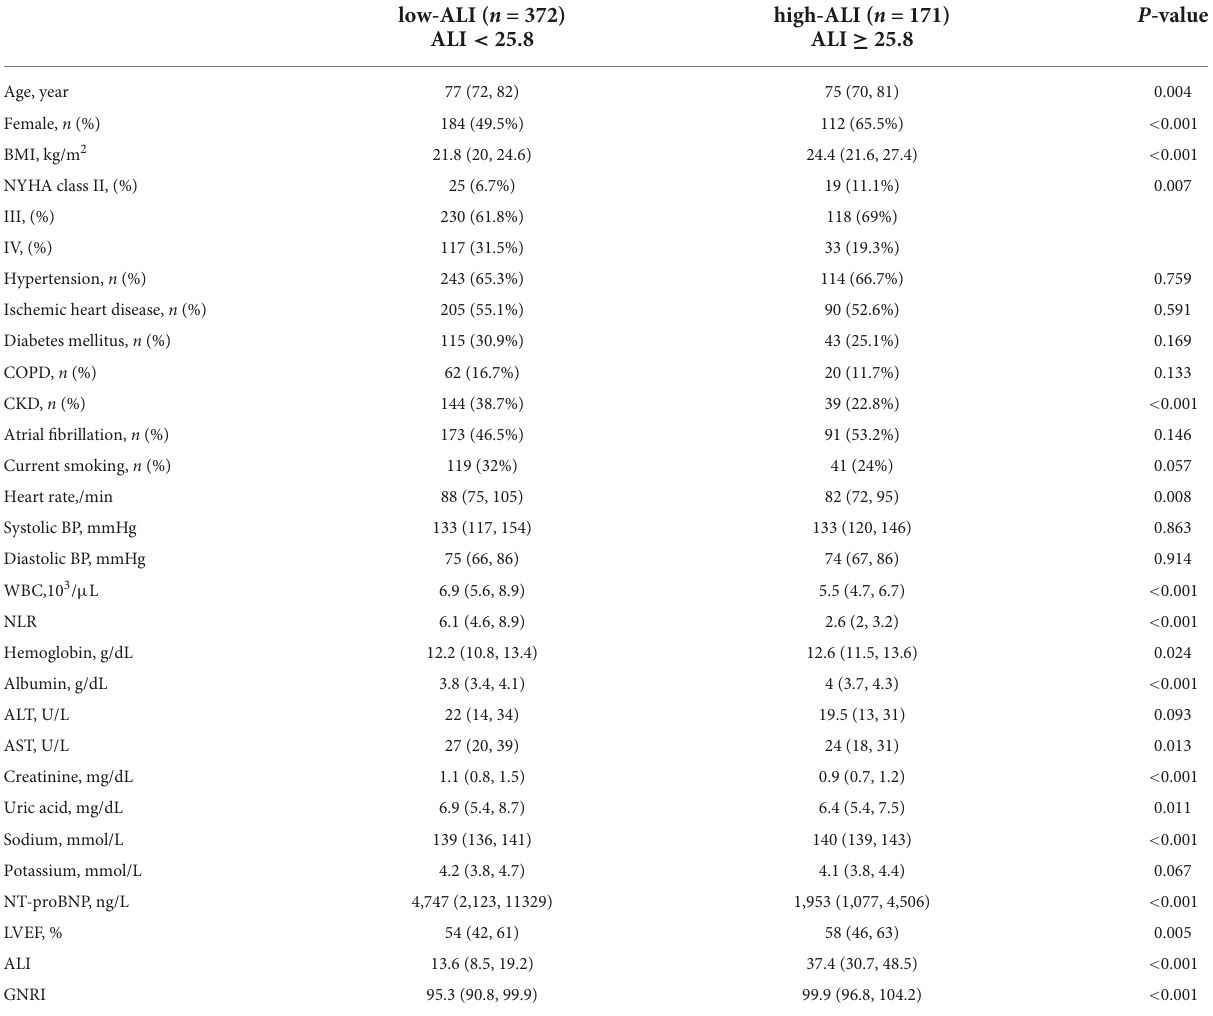
TABLE 1 Baseline characteristics of all patients.